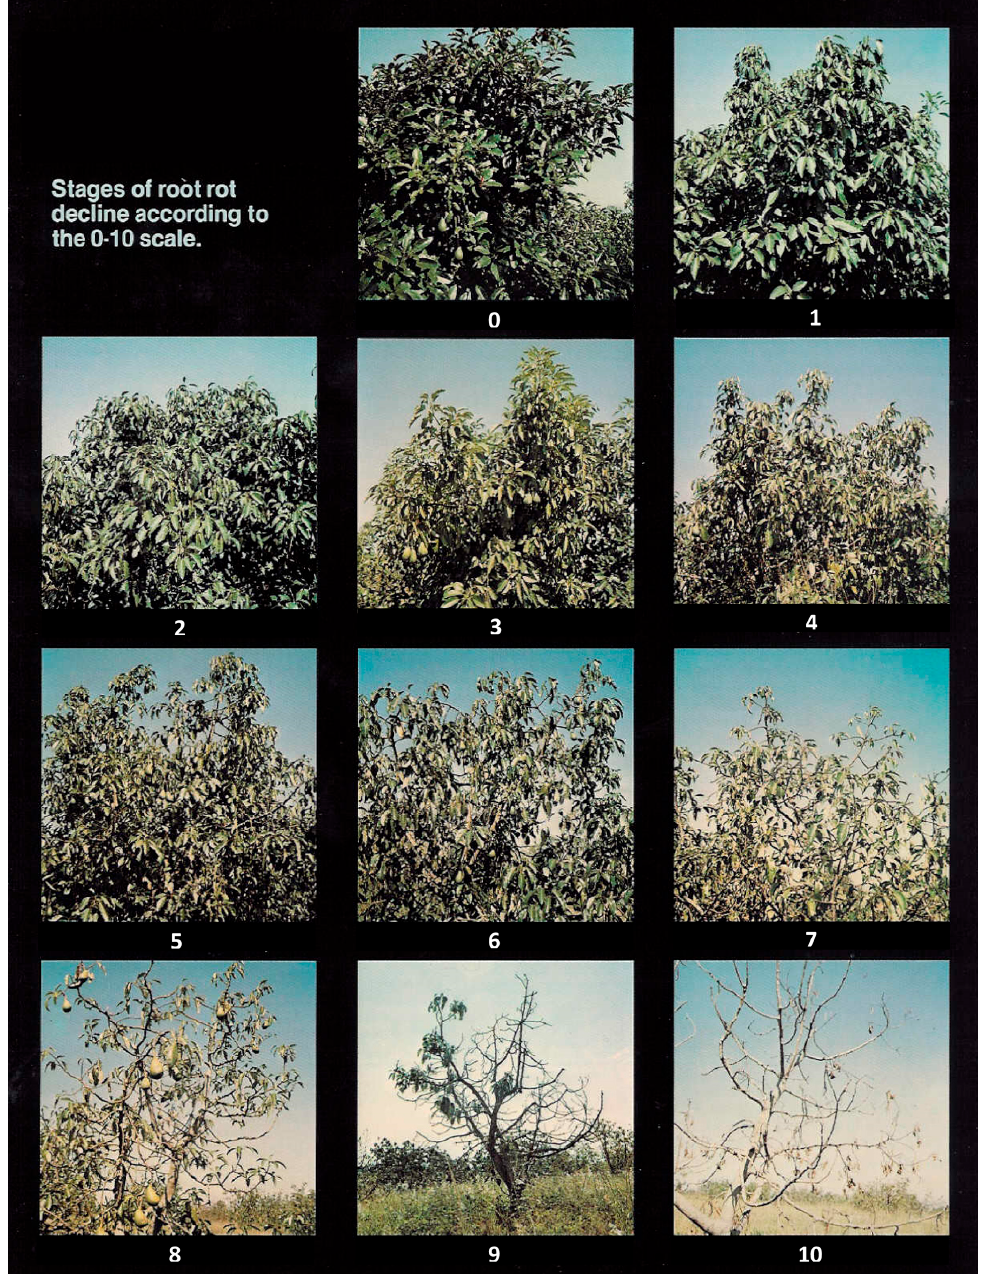
Figure 1. Ciba-Geigy Phytophthora root rot disease severity ranks (or canopy decline ranks) [6]. 0 & 1—Very healthy (no decline), 2—Healthy (no decline), 3—Early decline, 4—Early decline to moderate decline, 5—Moderate decline, 6—Moderate to severe decline, 7—Severe decline, 8—Very severe decline, 9—Almost denuded, 10—Complete denuded.